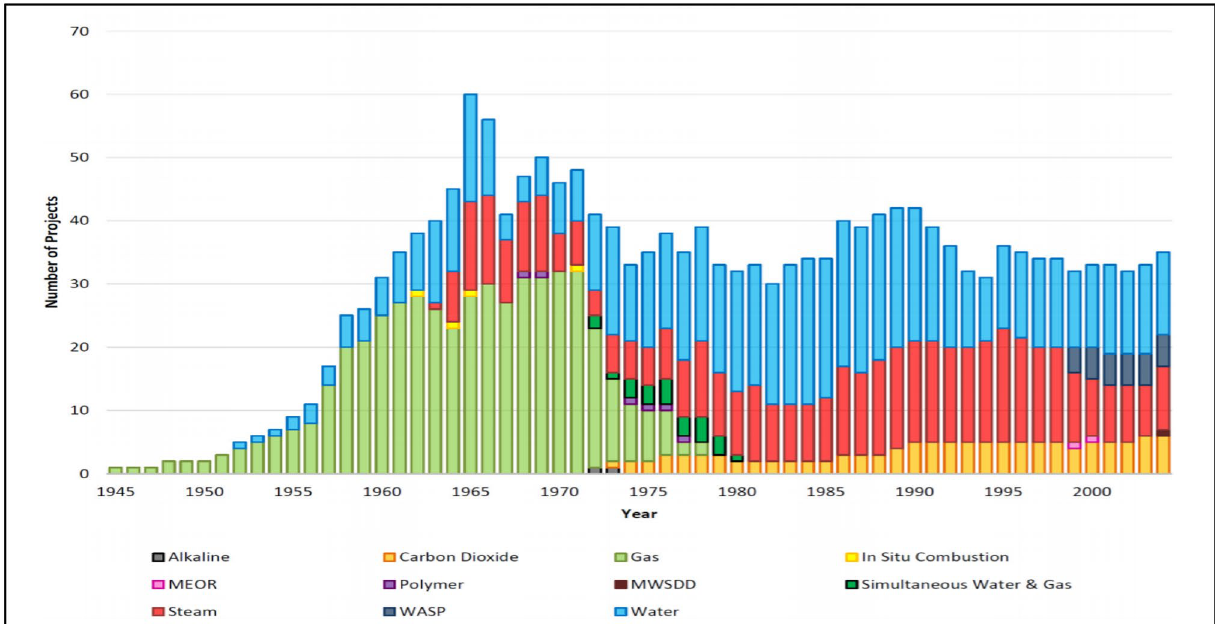
Fig. 2 Summary of IOR projects in Trinidad and Tobago (Source Sinanan et al.